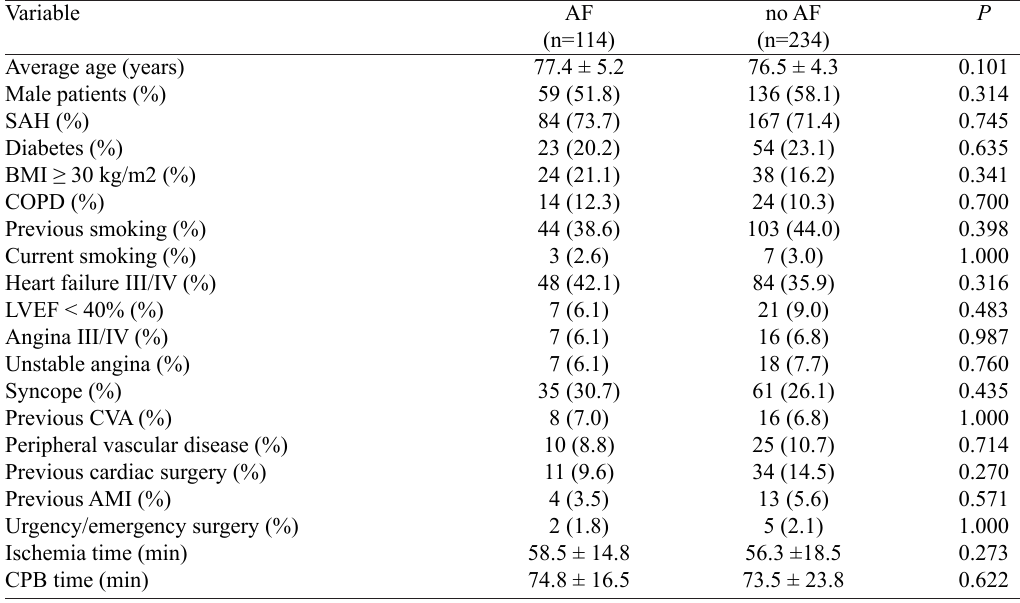
AF = atrial fibrillation; SAH = Systemic arterial hypertension; BMI = body mass index; COPD = chronic obstructive pulmonary disease; LVEF = left ventricular ejection fraction; CVA = cerebrovascular accident; AMI = acute myocardial infarction; CPB = cardiopulmonary